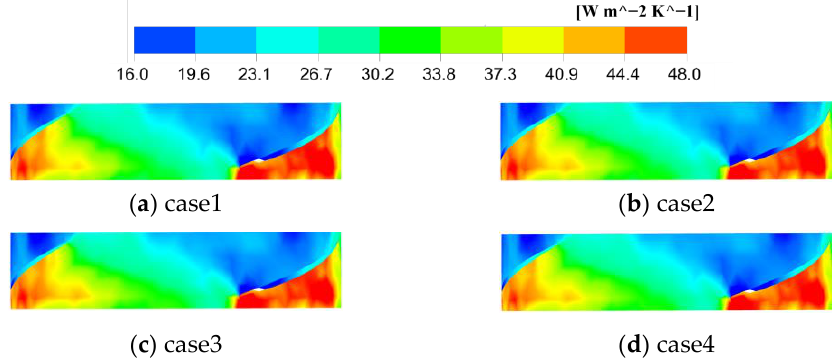
Figure 13. Entropy production contour at the rim.